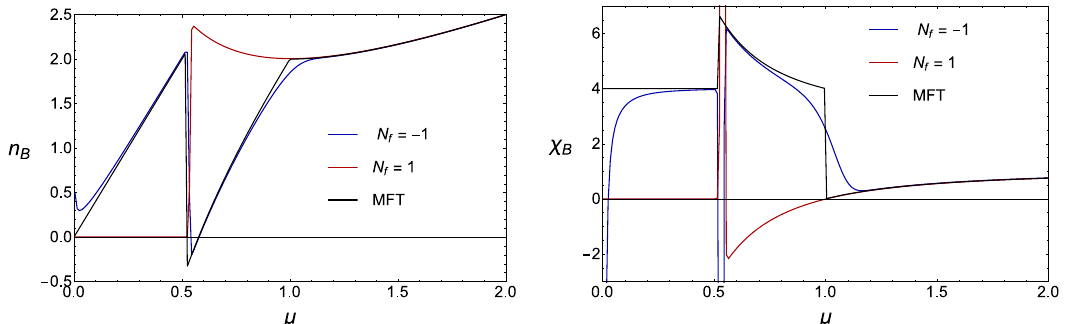
Figure 4 . The baryon number density (left) and baryon number susceptibility (right) as a function of the chemical potential, (cid:22) for n = 100 and m = 0. Results are give for the fermionic partition function (red), the bosonic partition function (blue), and the mean (cid:12)eld limit of the bosonic partition